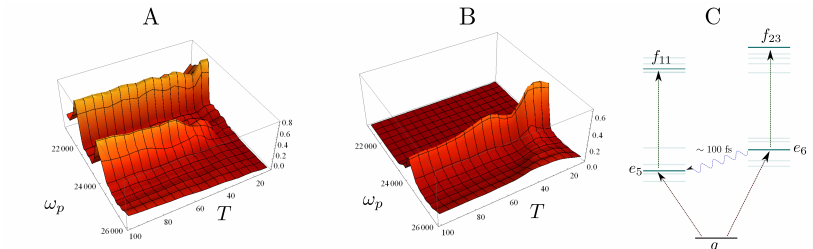
Fig. 3. The variation of the populations of the two-exciton states f 11 (A) and f 23 (B) with the pump frequency and the entanglement time. C: excitation pathways and population decay channel for the two states.